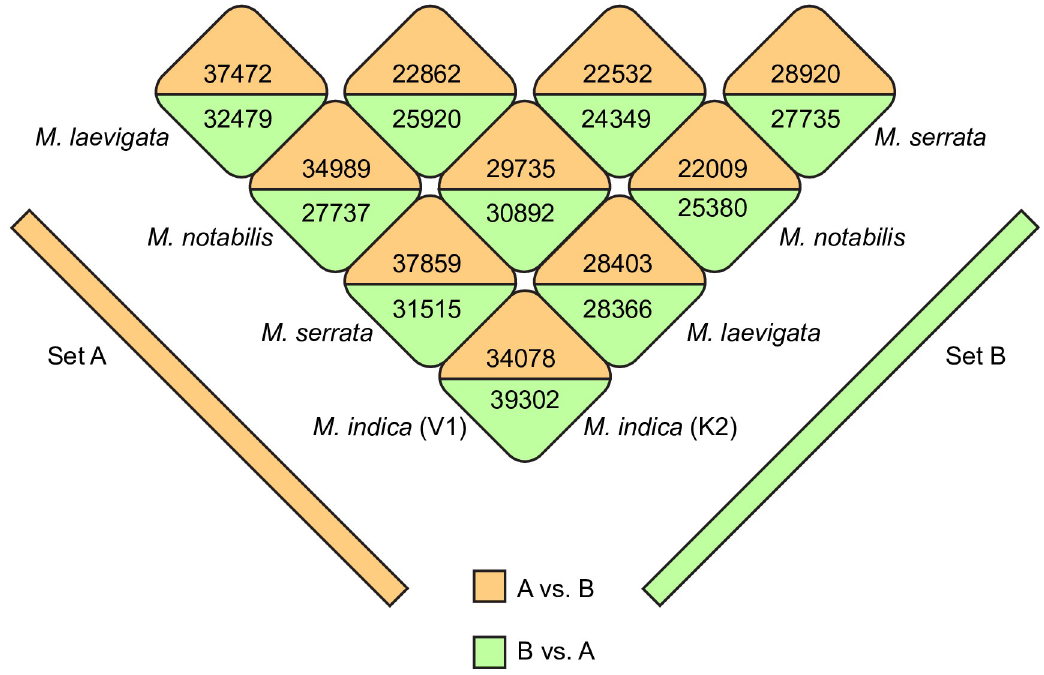
Fig 1. Figure showing the number of orthologs reported in assembled transcriptomes from different genotypes using Proteinortho. Trinity assembled transcriptome was used with default parameters. Numbers represent the transcripts in one to one comparison when reference transcriptome was used as query as well as source. See legend for